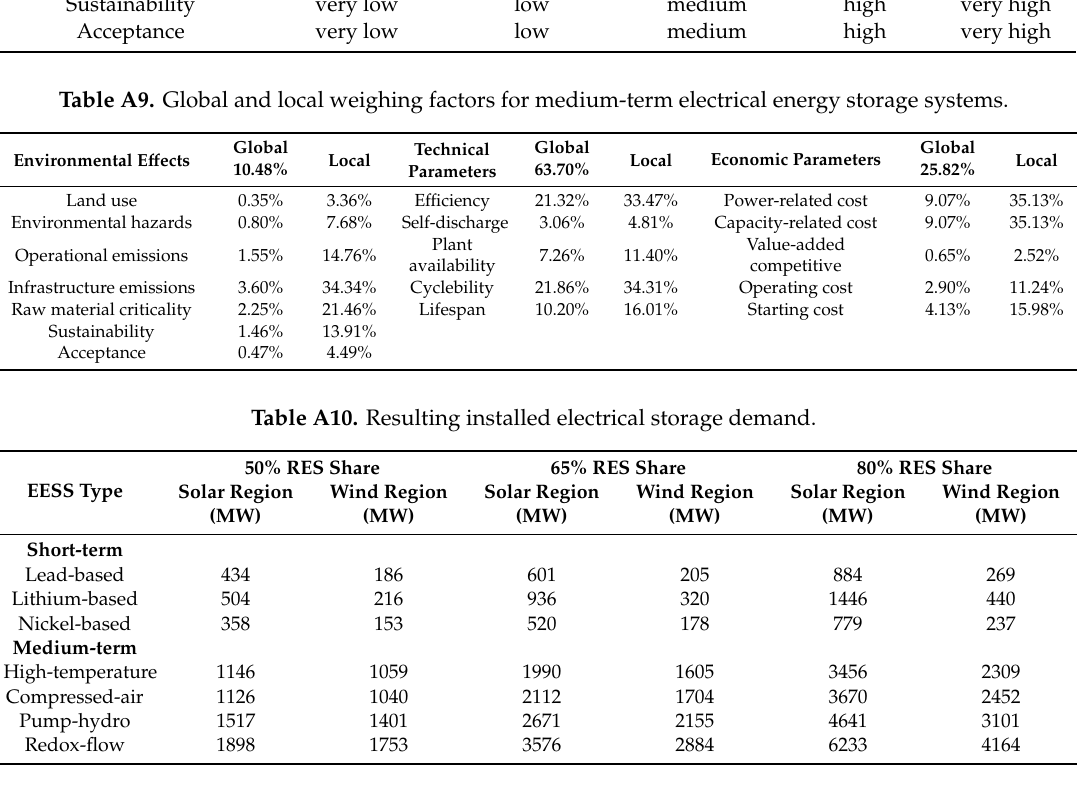
Table A11. Overview of the modelled characteristics of fossil fueled power plants, flexible bioenergy plants and